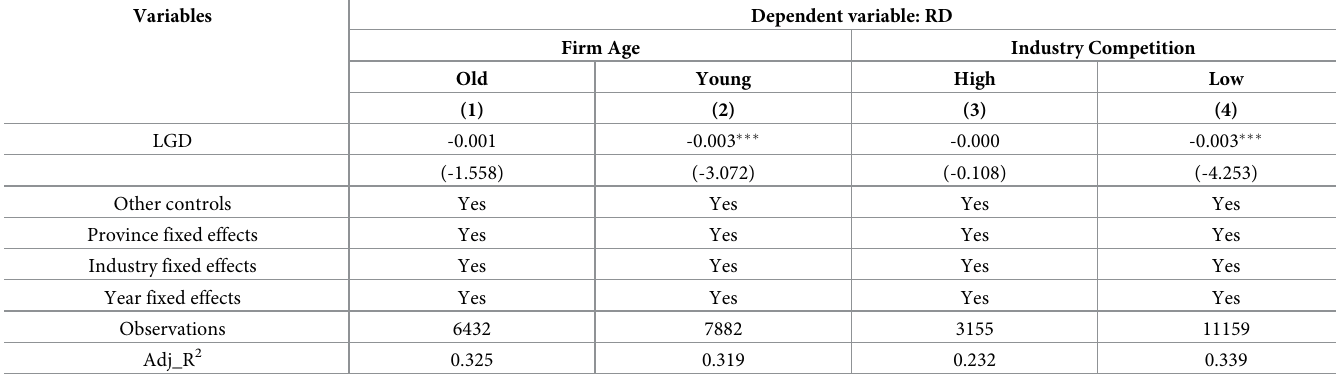
Table 7. Cross-sectional analysis